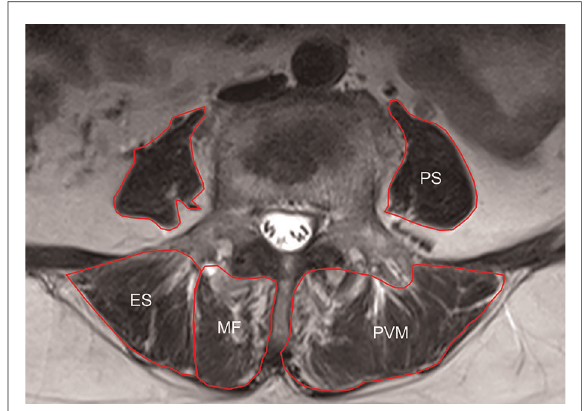
FIGURE 2 Schematic diagram of MRI horizontal paraspinal muscle measurement: multi fi dus (multi fi dus, MF), erector spinae (ES), psoas (psoas, PS) and paravertebral muscle (PVM).